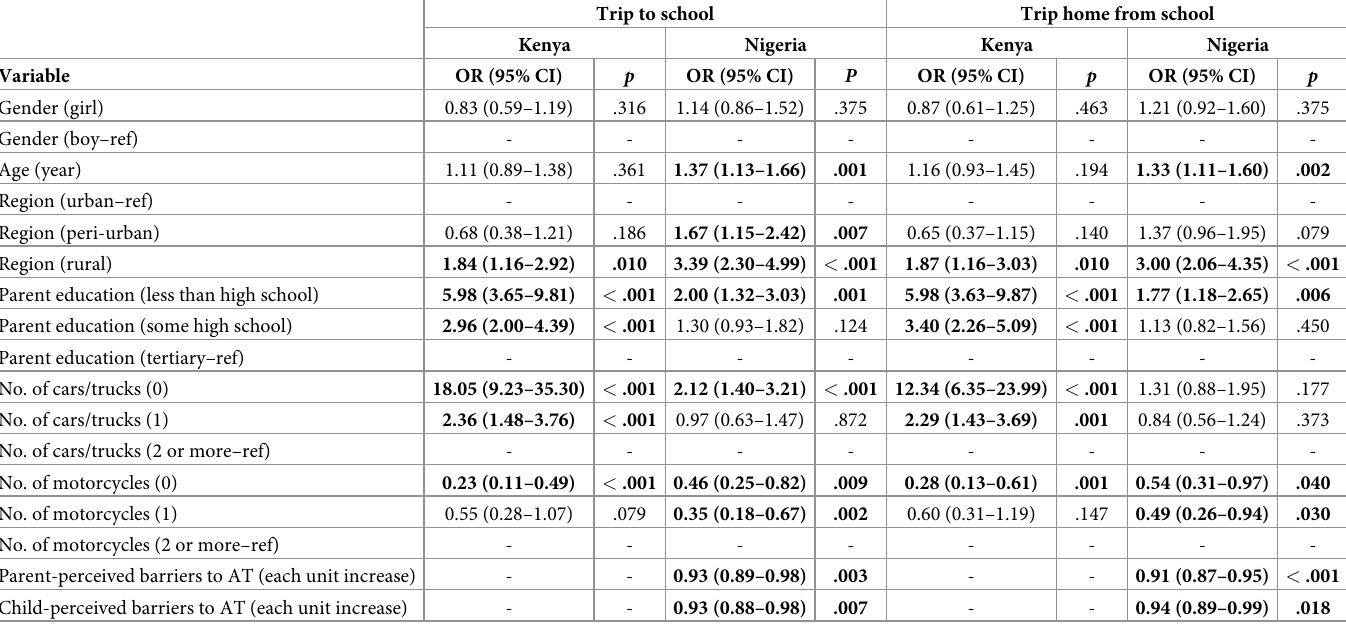
Table 4. Correlates of travel mode to school stratified by country in multivariable